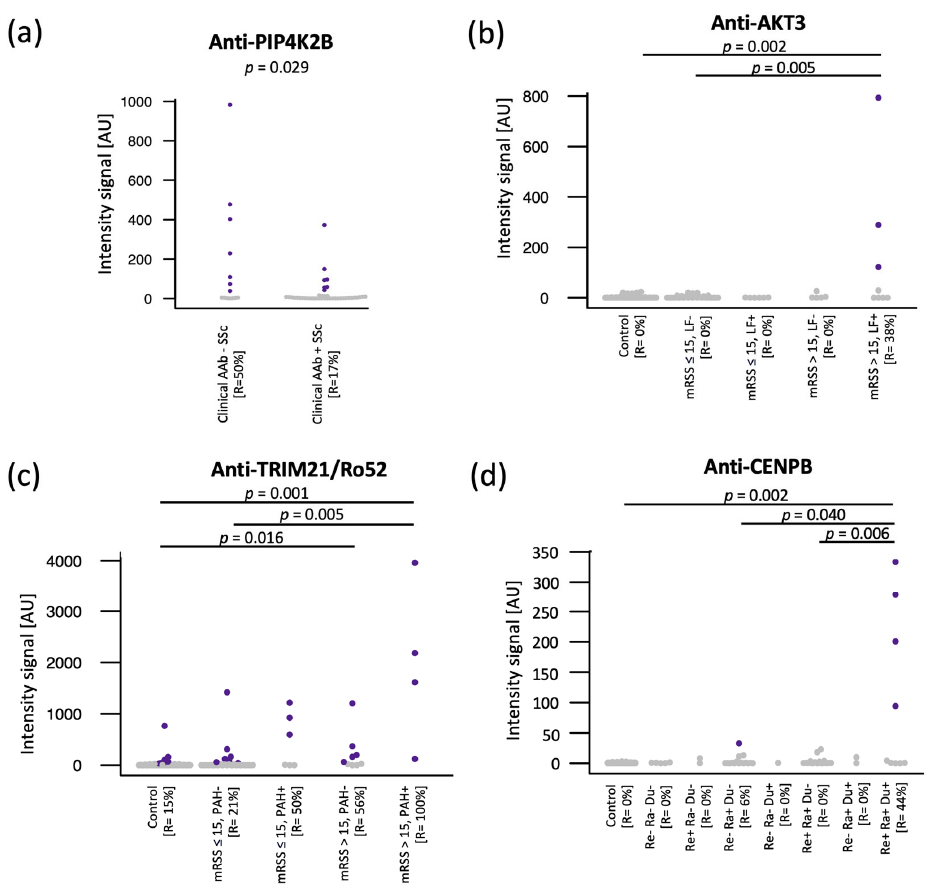
Figure 3. Autoantibodies associated with subgroups of SSc patients. ( a ) Anti-PIP4K2B antibodies were detected in 7/14 (50%) of the SSc patients negative for the clinical autoantibody (AAb) panel: anti-TOPO-1/Scl70, anti-centromere, anti-Rnp/Sm, anti-Rnp70, anti-SSA/Ro, anti-SSB/La, and anti- Sm in clinical tests. ( b ) Anti-AKT3 autoantibodies were detected at high levels in SSc patients with lung fibrosis (LF) and active skin fibrosis with mRSS > 15. ( c ) Anti-TRIM21/Ro52 showed the highest prevalence (100%) and intensity in SSc patients with both PAH and mRSS > 15. ( d ) Anti-CENPB antibodies were detected at high levels in patients with digital ulcers (Du), Raynaud (Ra), and re fl ux (Re). Each dot represents one sample. Purple dots indicate samples where the autoantibody passed the cuto ff of reactivity. Group comparisons were carried out by Fisher´s Exact test. p < 0.05, cuto ff for signi fi cance; mRSS: Modi fi ed Rodnan skin score.